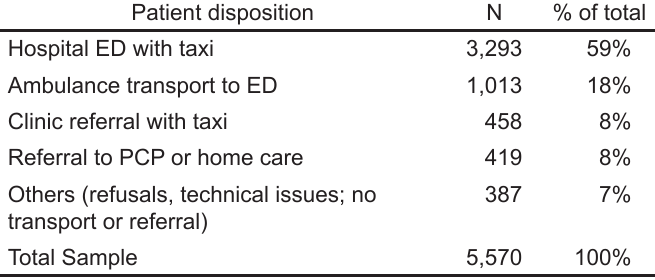
Table 2. Patient disposition intervention in an emergency telehealth and navigation program